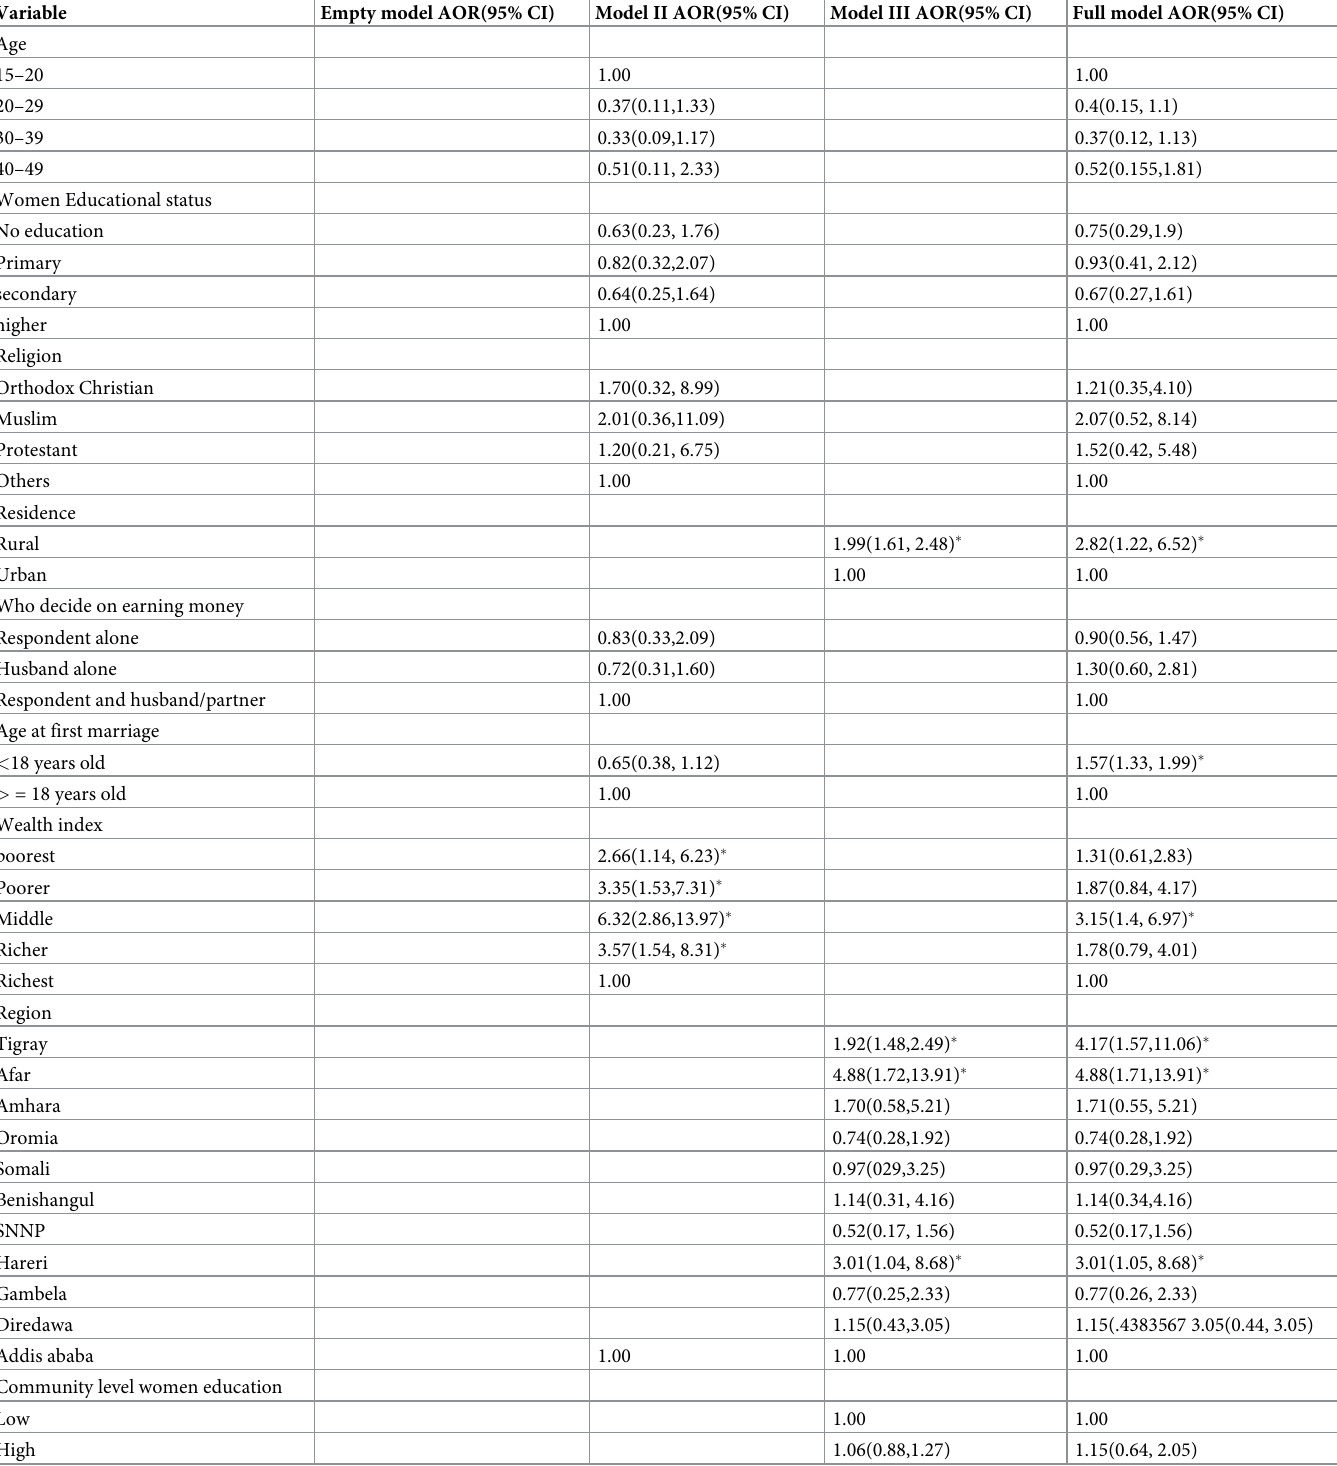
Table 3. Multilevel multivariable logistic regression of the individual and community related variables associated nutritional status of non- pregnant reproductive age women, Ethiopia,